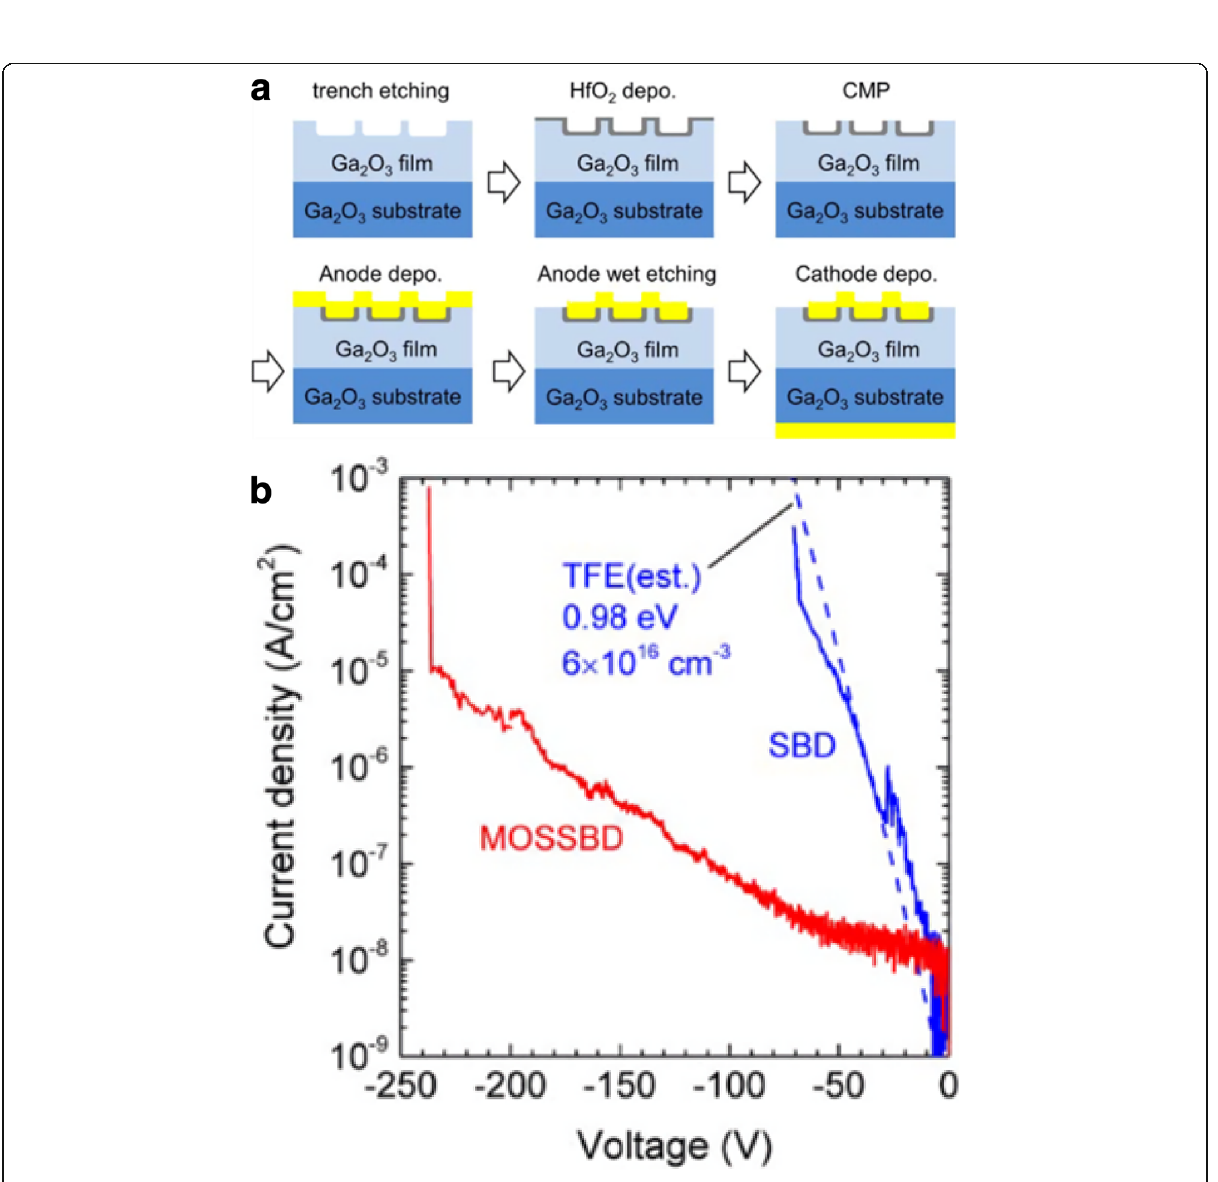
Fig. 10 a Fabrication processes of the MOS-type Ga 2 O 3 SBD with trench termination structure. b Comparison of the reverse characteristics of the Ga 2 O 3 SBDs with and without trenches. Reprinted from ref.